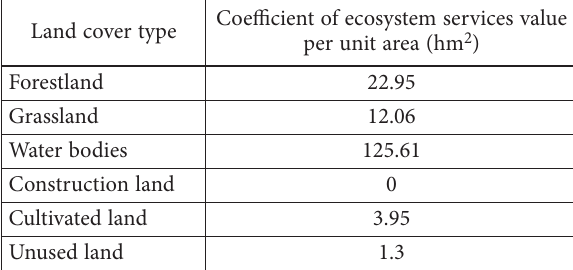
Table 2. Ecosystem service equivalent value of different